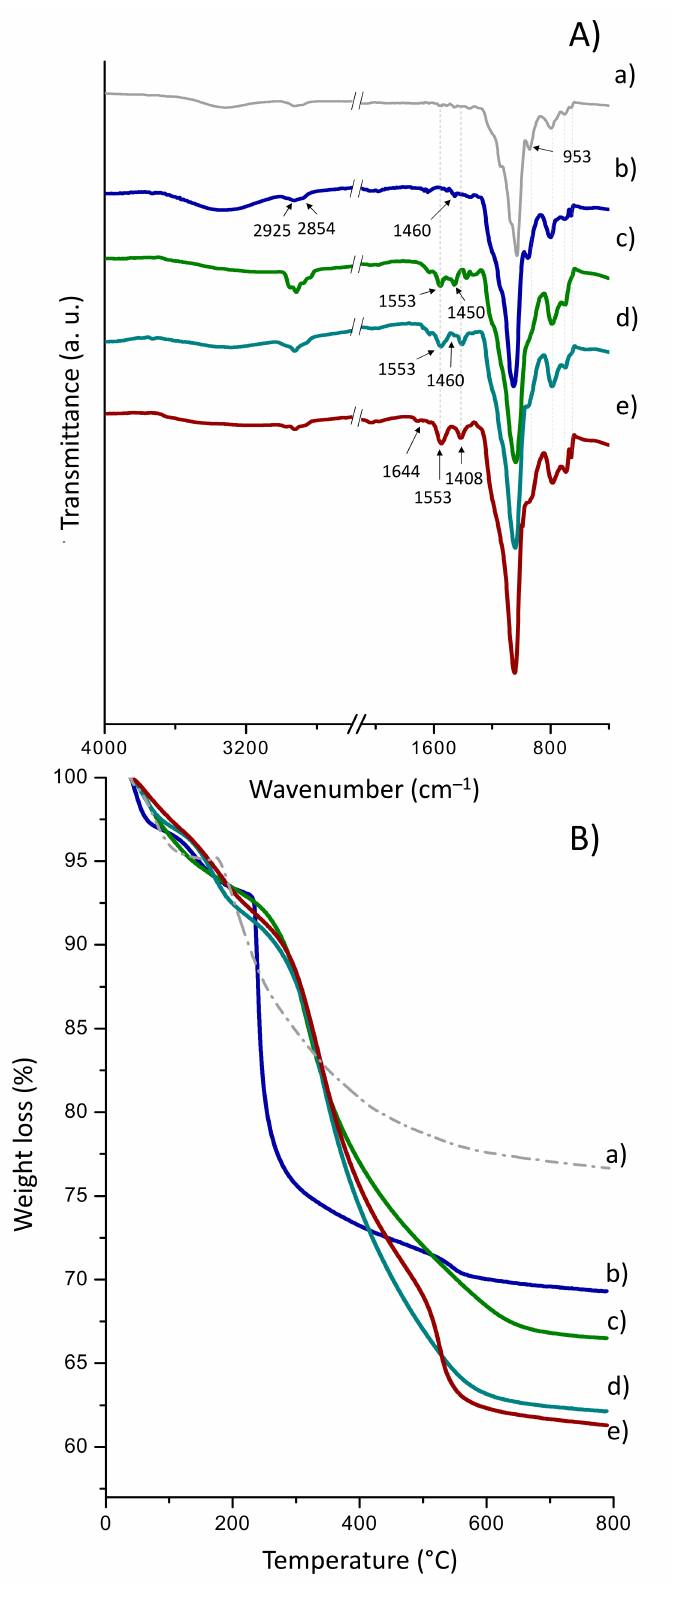
Figure 4. ATR FTIR spectra ( A ) and TG curves ( B ) for ( a ) as-synthesized Sihgel, ( b )